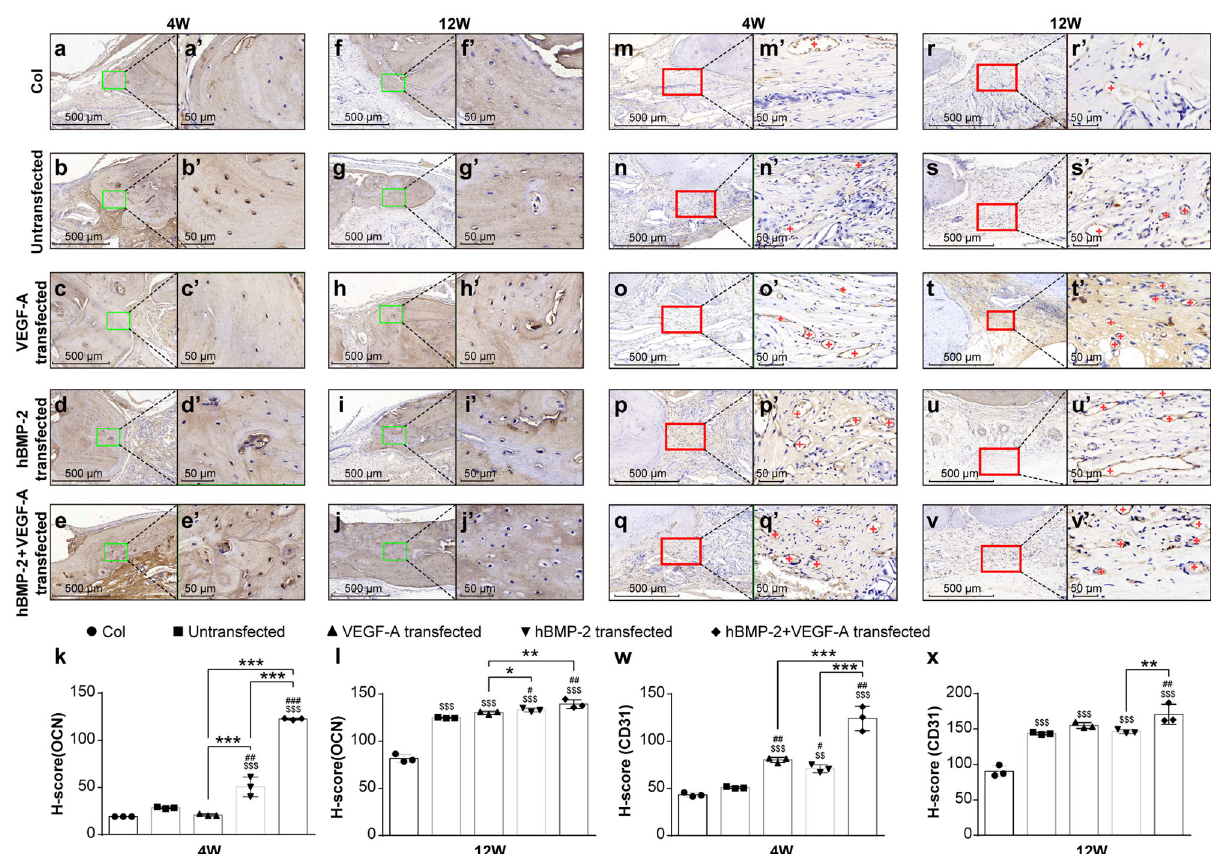
Fig. 5 BMSC-scaffolds containing modBMP2 and modVEGF-A intensify the stimulation of new bone formation. a – j Representative photomicrographs of sectioned and Osteocalcin (OCN) stained bone tissue in the defect areas at 4 weeks ( a – e ) and 12 weeks ( f – j ) post-treatment, respectively. The rectangular areas in images a – j correspond to magni fi ed areas in images ( a ’– j ’ ). Note the higher quantity of OCN-positive cells in the modBMP2 + modVEGF-A treatment group. k , l Quanti fi ed assessment of OCN-positive cells at the site of regenerating bone in indicated groups at 4 weeks and 12 weeks respectively. m – v Representative photomicrographs of sectioned and CD31 stained vessels in the defect areas at 4 weeks ( m – q ) and 12 weeks ( r – v ) post- treatment, respectively. The rectangular areas in images m-v correspond to magni fi ed areas in images ( m ’– v ’ ). Note ( + ) indicates blood vessels in the regenerating area, increased vessel densities in 1B1V treatment group are seen. w , x Quanti fi cation of CD-31 immuno-labeling of the indicated treatment groups at 4 and 12 wks post-injury, respectively. Differences between these groups were calculated by one-way ANOVA test, n = 6. Data was represented as the mean ±